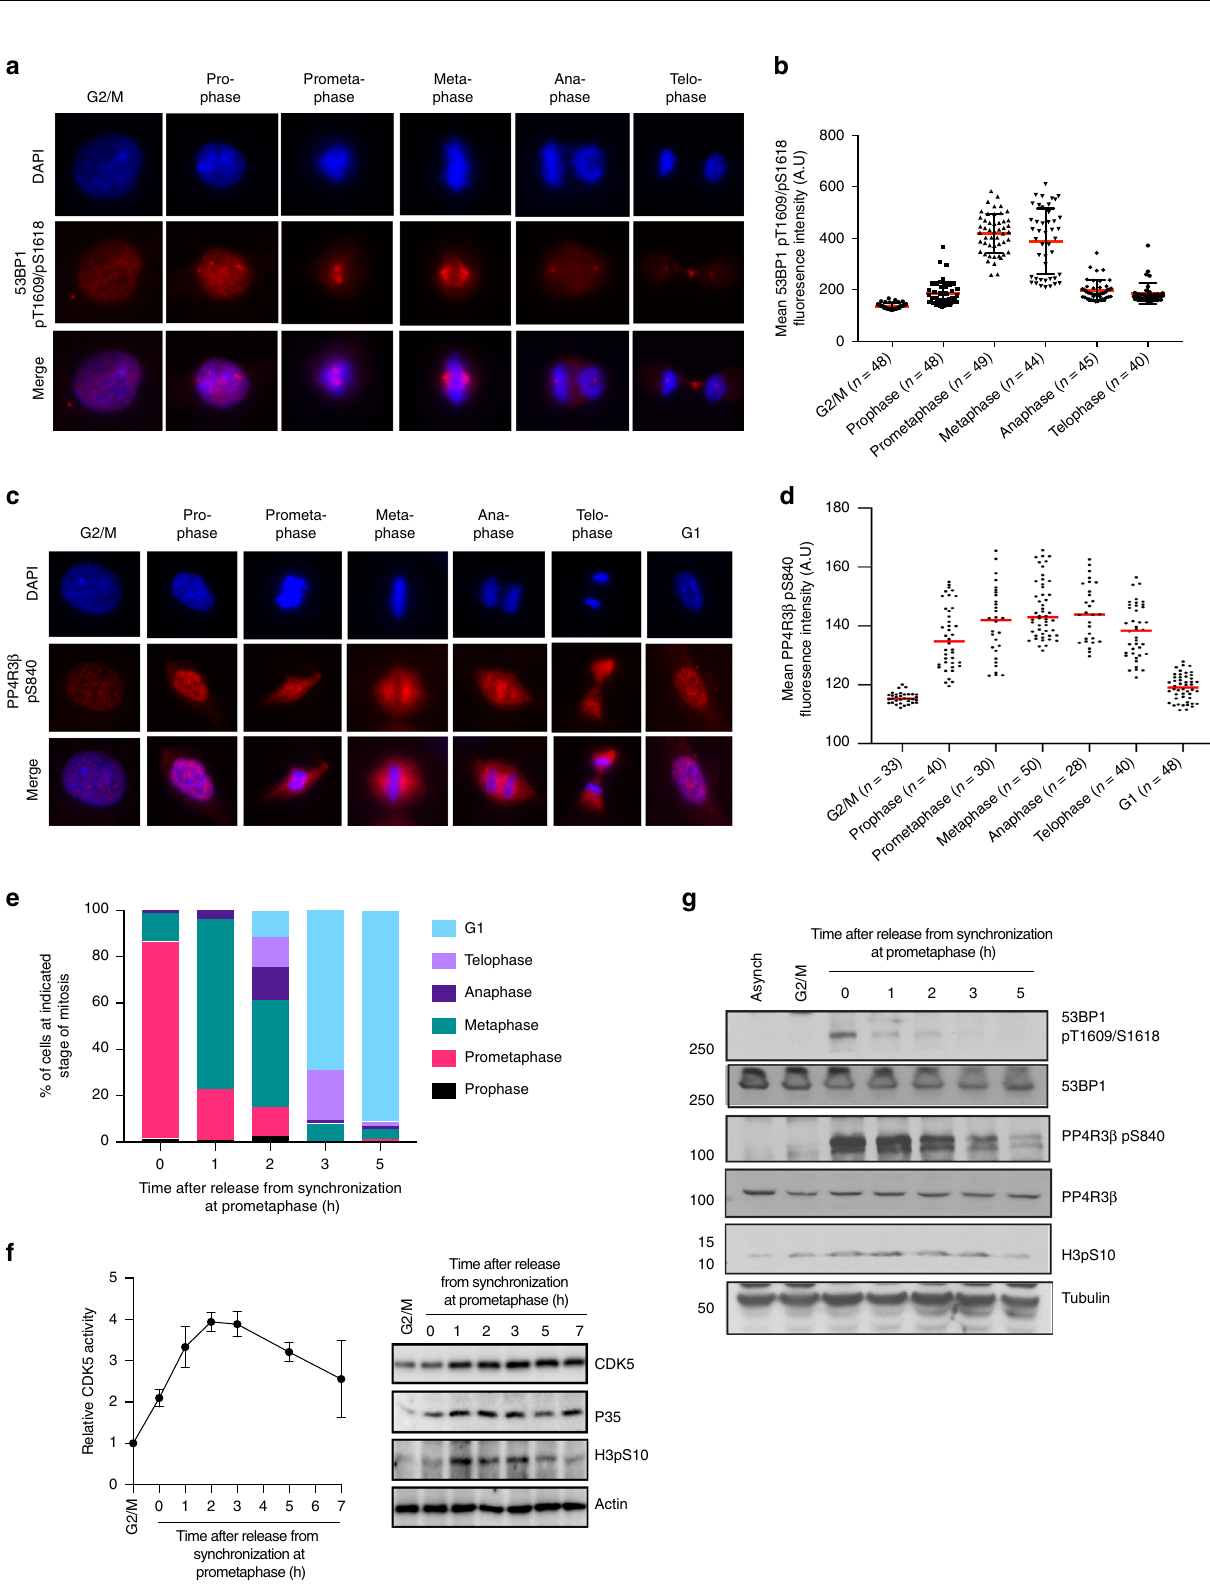
min onward after release from nocodazole-induced arrest (Fig. 3g, h). Collectively, these results indicate that PP4R3 β is indeed a bona fi de substrate of CDK5 during mitosis. CDK5 regulates 53BP1 recruitment to damaged chromatin . Since speci fi c inhibition of CDK5 abrogates phosphorylation